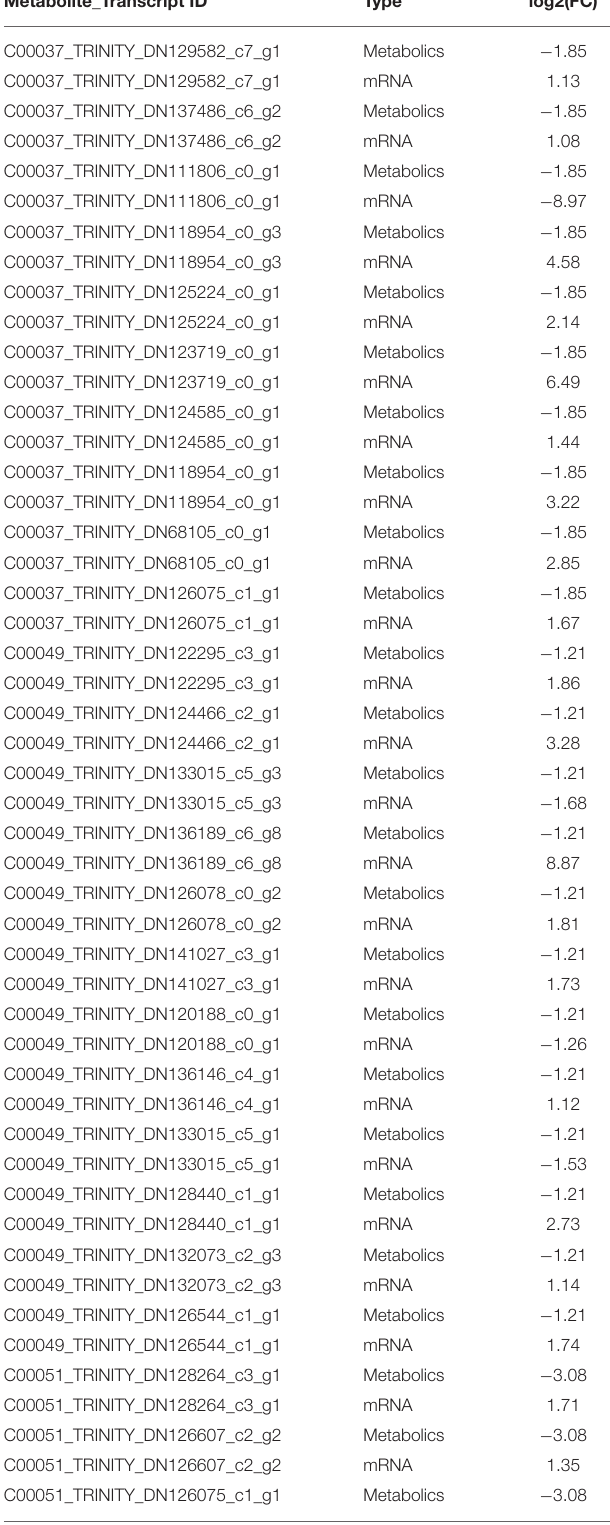
TABLE 7 | Results of differential co-expression of ovarian metabolites and related transcripts in Zi-geese. Metabolite_Transcript